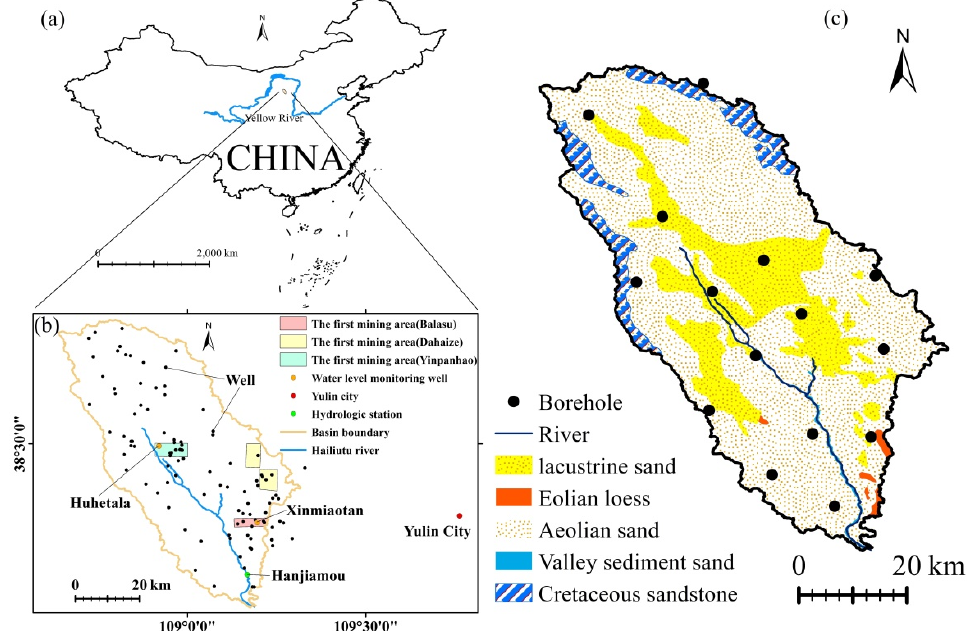
Figure 1. Location of the study area: ( a ) Location of the studied river basin in China; ( b ) Location of wells, hydrological stations, and first mining areas of coal mines in the basin; ( c ) Borehole drilling sites and geological background.